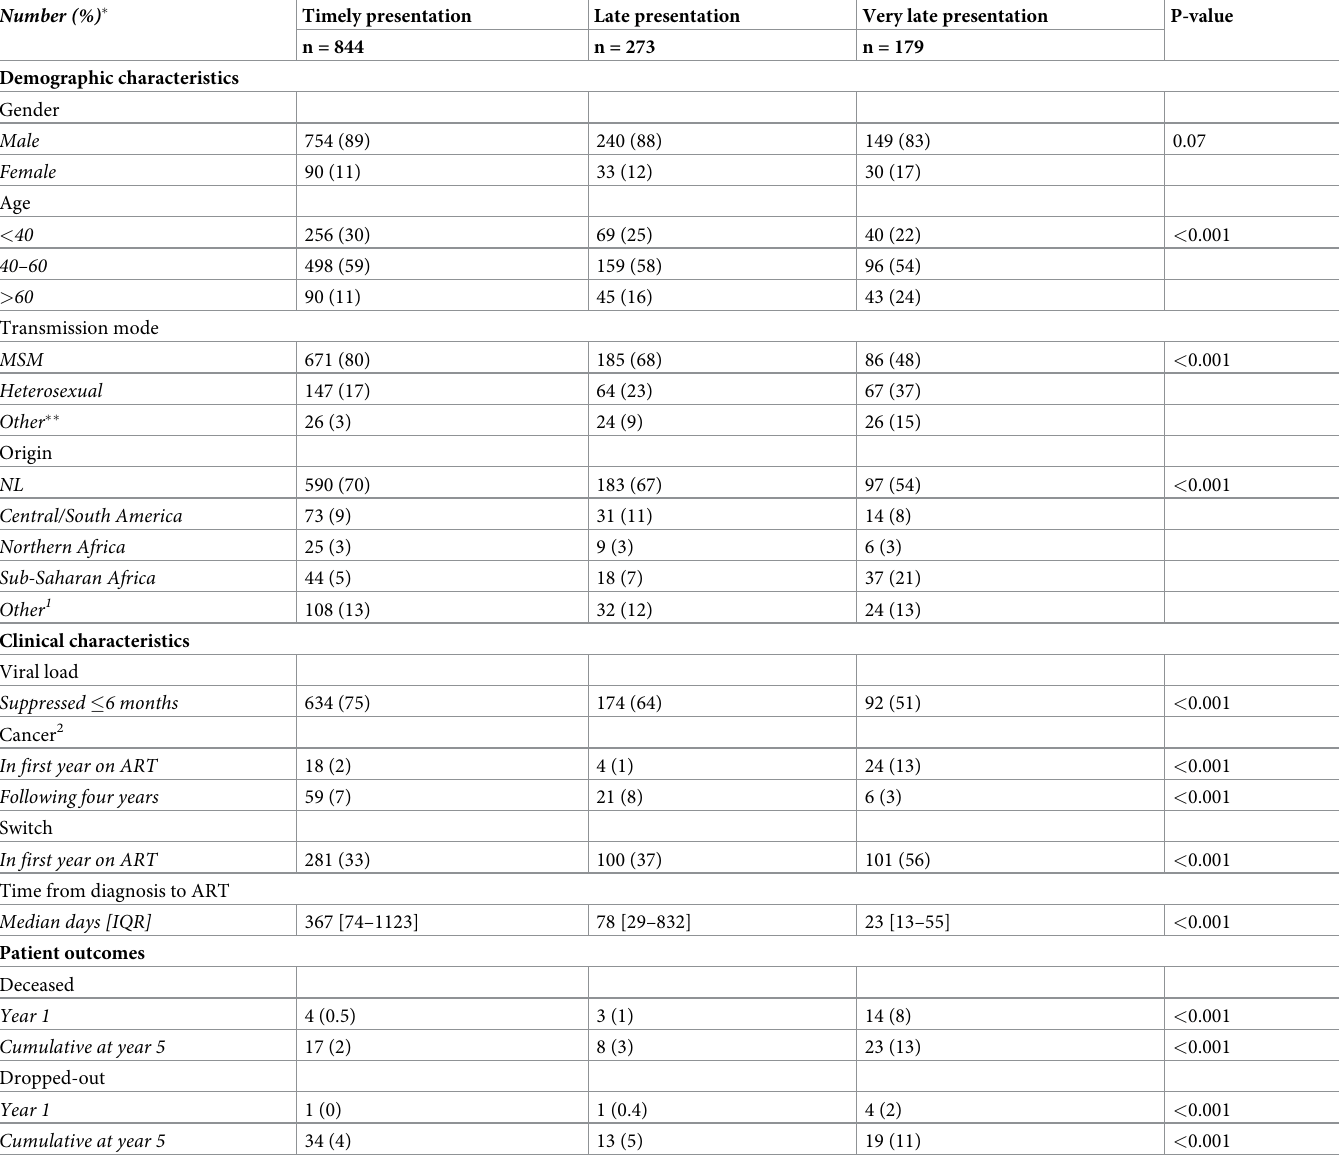
Table 1. Baseline characteristics of n = 1296 PLWH who initiated ART between 1 January 2013 and 31 December